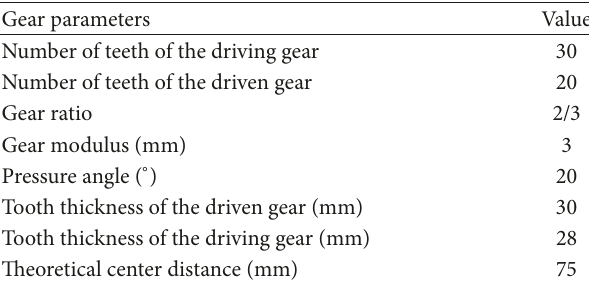
Table 1: Parameters of the gear